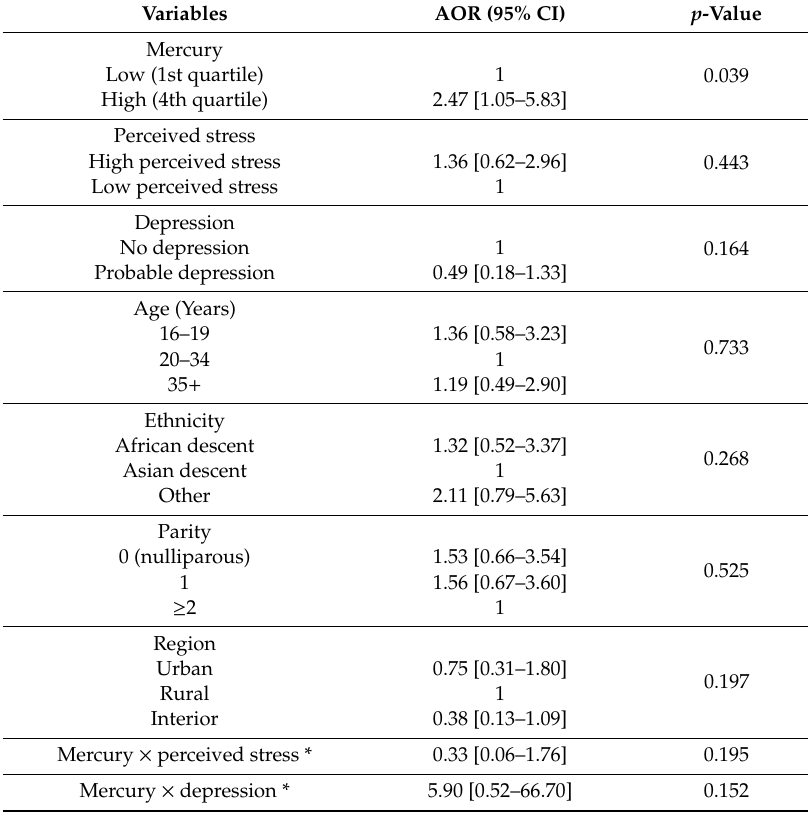
Table 5. Multivariable model for preterm